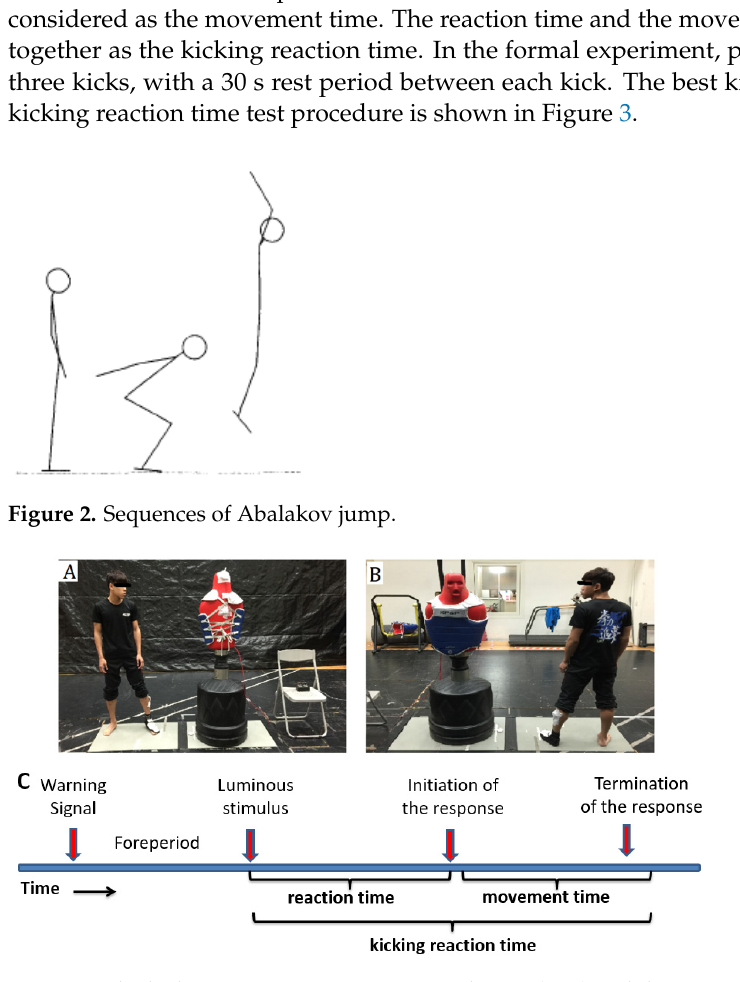
Figure 2. Sequences of Abalakov jump.